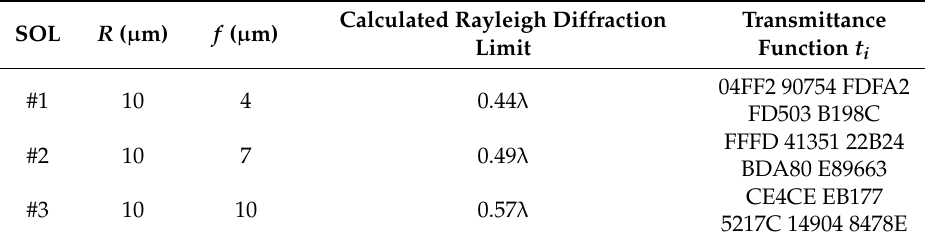
Table 1. Design parameters and transmittance functions of the optimized binary amplitude-type masks.